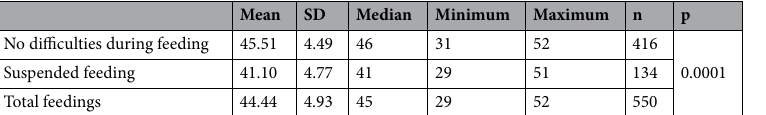
Table 5. Evaluation of discriminant validity by comparing means of the OFEATINg scale between the groups that did not have any difficulties during feeding and those that were suspended feeding.